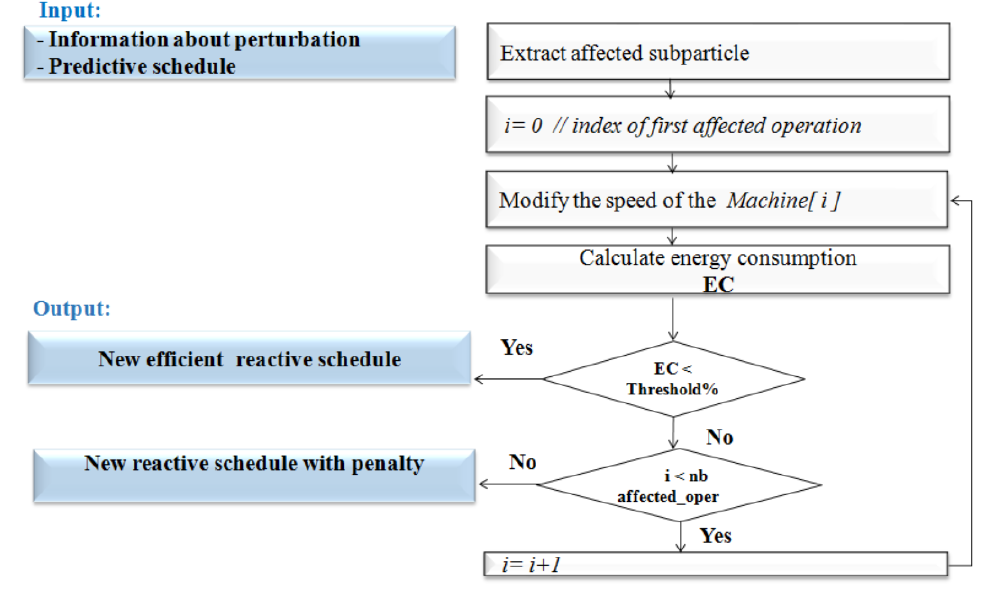
Figure 6. Flow chart of the first rescheduling method.